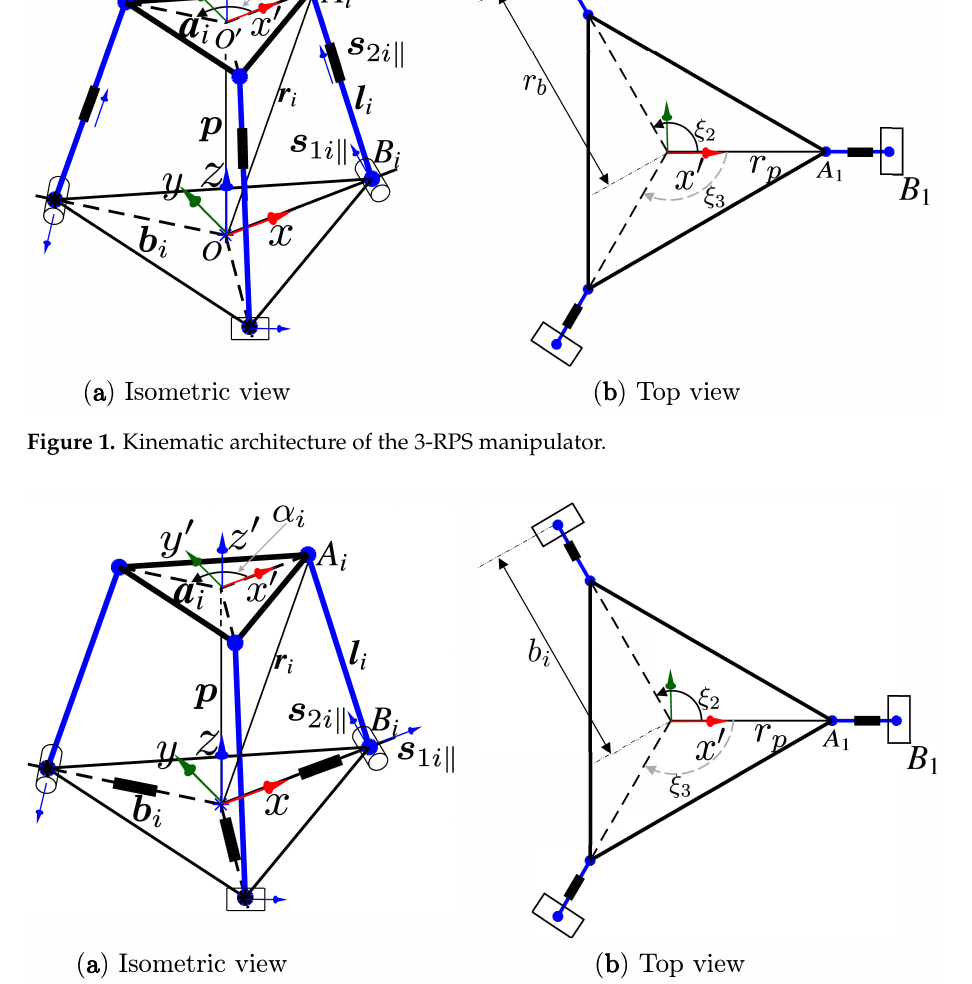
Figure 2. Kinematic architecture of the 3-PhRS